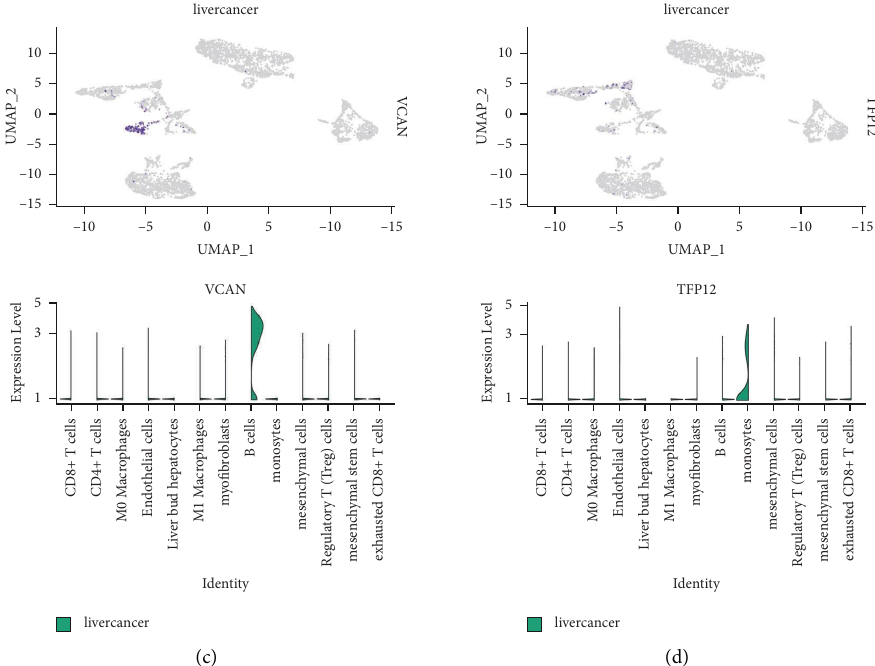
Figure 9: (a) Diferent groups’ distributions of cell proportions. (b) Expression map of SERPINE1 in diferent groups. (c) Expression map of VCAN in diferent groups. (d) Expression map of TFPI2 in diferent